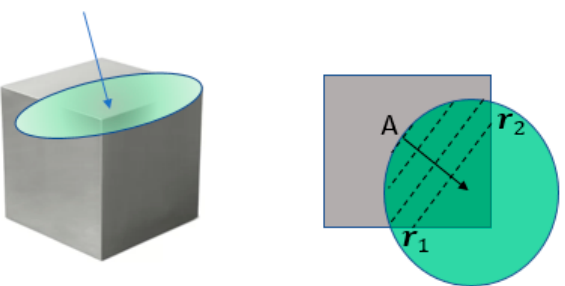
Figure 2. Interaction between a laser delta-pulse and the object. The 3D view on the left and the 2D top-view on the right.